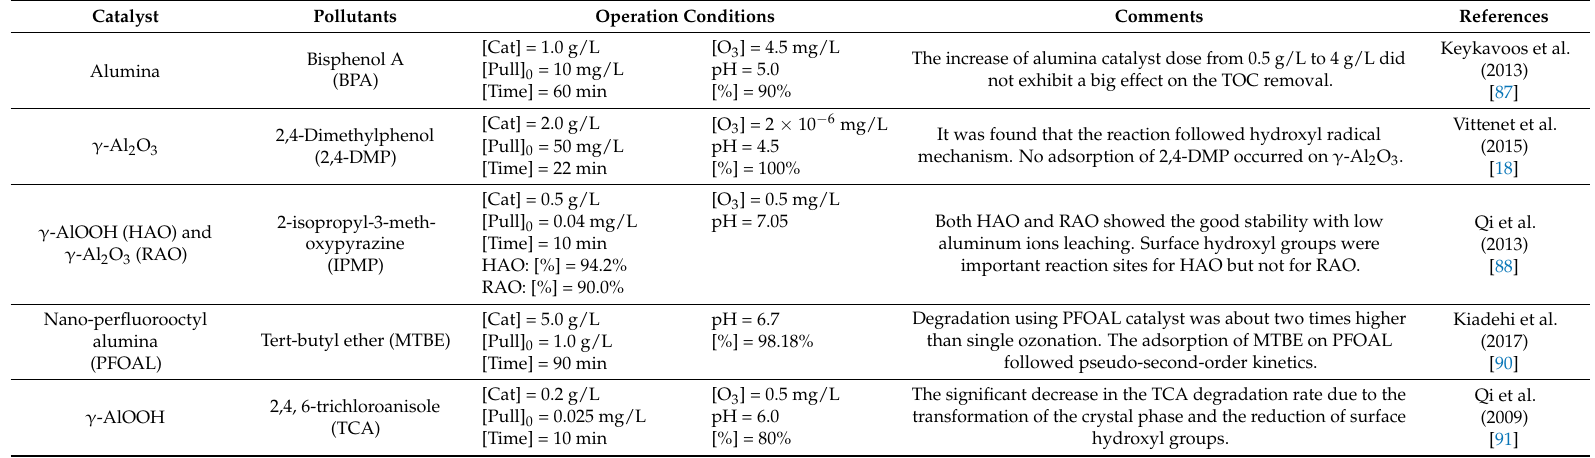
Table 6. Aluminum oxides for catalytic ozonation